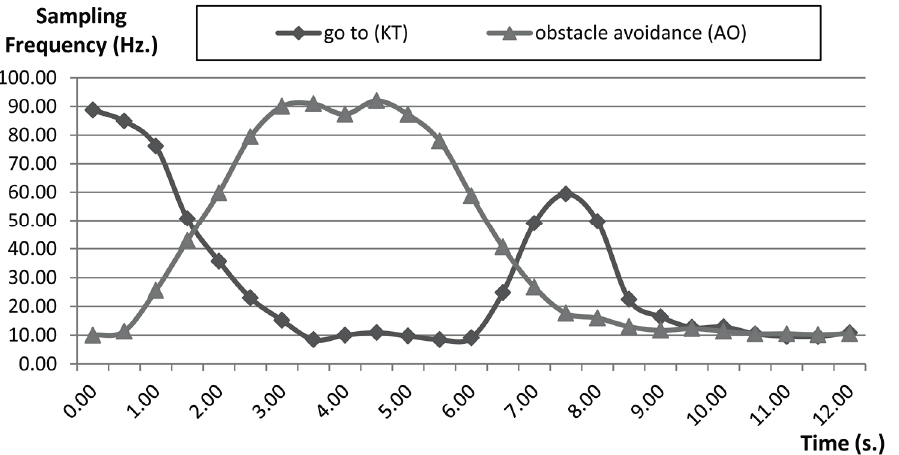
Figure 29. Optimisation of the sampling rate of “go to or keep track (KT)” behaviour during navigation (Path